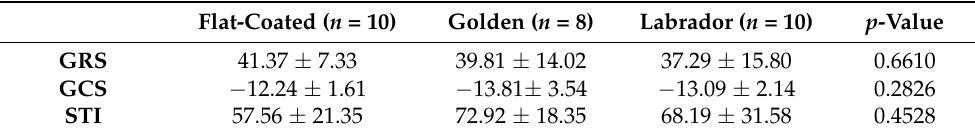
Table 3. Two-dimensional speckle-tracking echocardiographic parameters of three clinically healthy Retriever breeds.